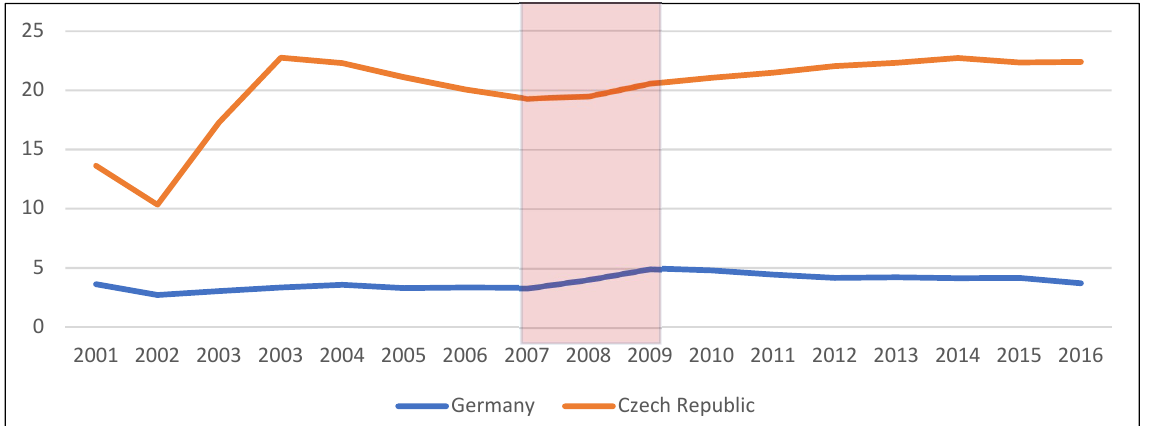
Figure 2. Share of zombie firms on total companies in %.